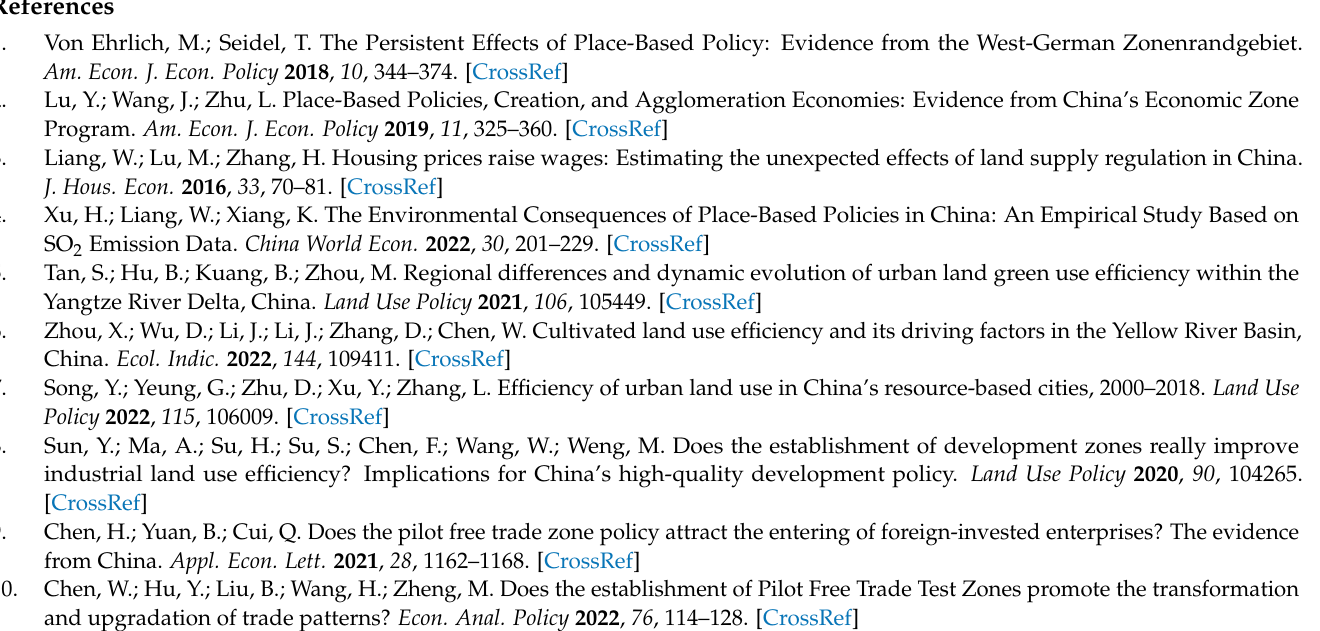
China’s land area is about 9.6 million square kilometers, including 34 provincial administrative regions (including Hong Kong, Macao and Taiwan). Assuming that each province is circular, the average radius of a province is over 300 km, whereby the maximum value of s is limited to 400